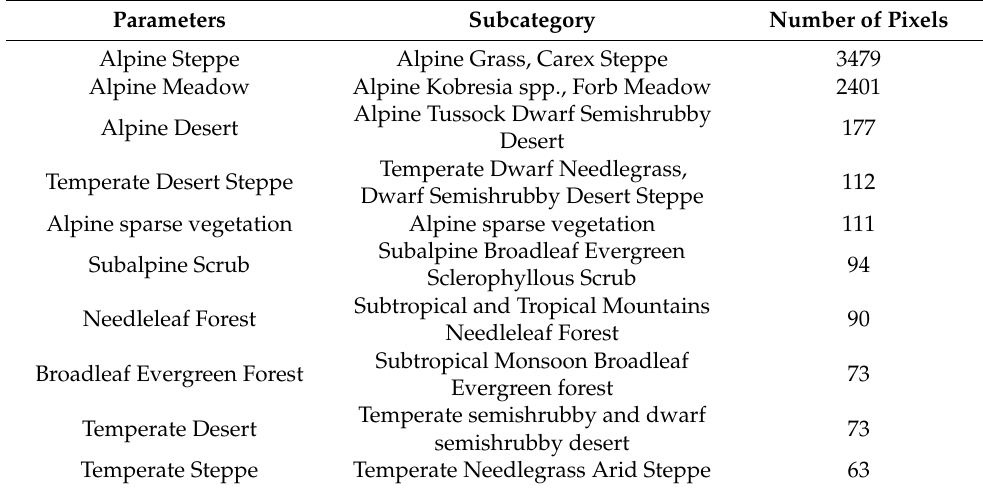
Figure 3. The spatial distribution of ten dominant vegetation types of Tibetan Plateau overlapped with meteorological stations. Table 2. Ten dominant vegetation types with pure pixels, their ecosystems, and the number of